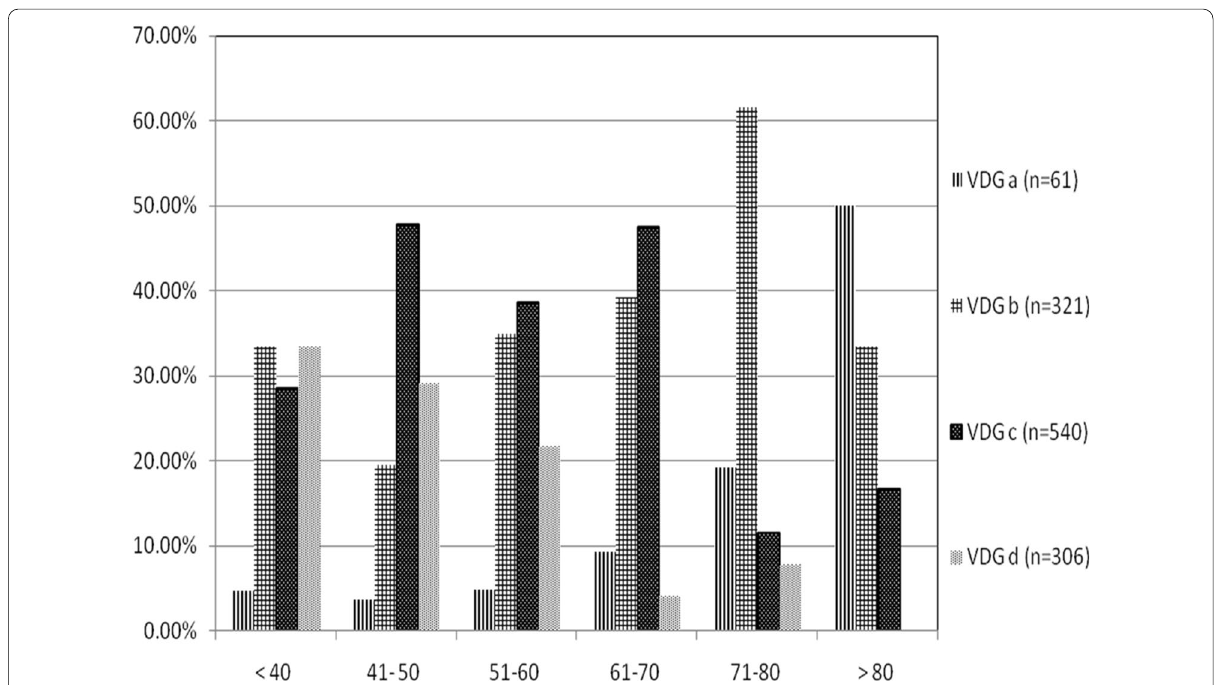
Fig. 5 Bar chart shows age wise distribution of different volumetric density grades (VDG) in study population